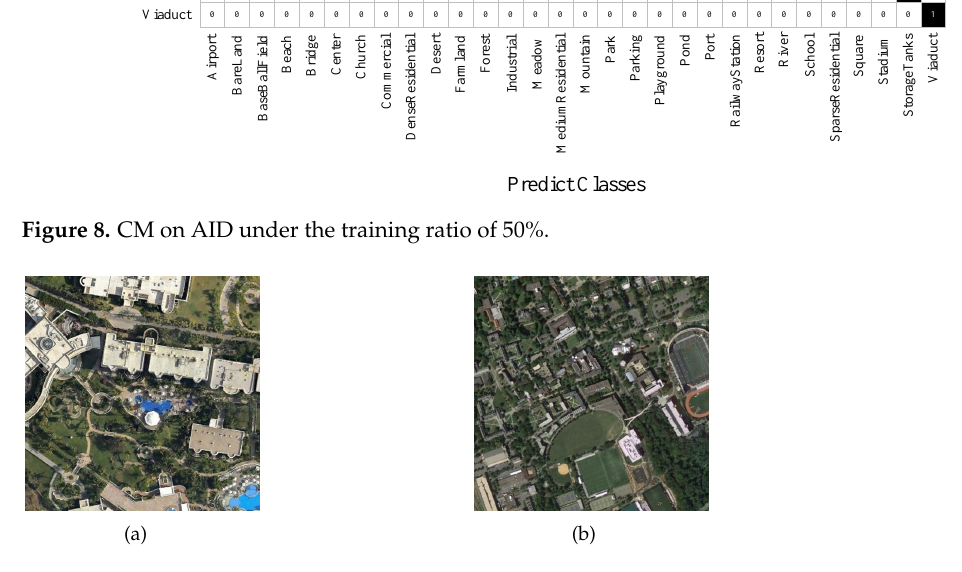
Figure 9. The misclassified images from resort. ( a ) The image of resort. ( b ) The image of school misclassified as